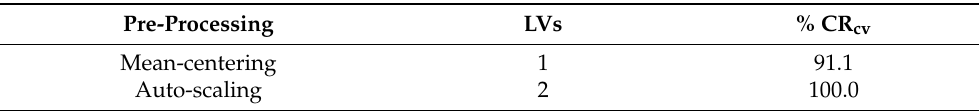
Table 3. PLS-DA analysis. Pre-processing, number of latent variables (LVs), and average cross- validated classification